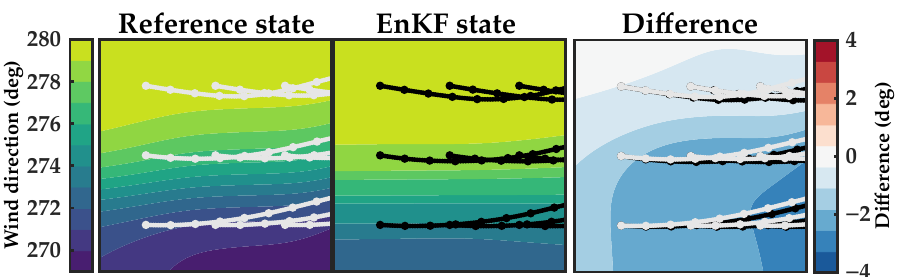
Figure 6. Estimated background flow field wind direction compared to the reference at t = 564 s.